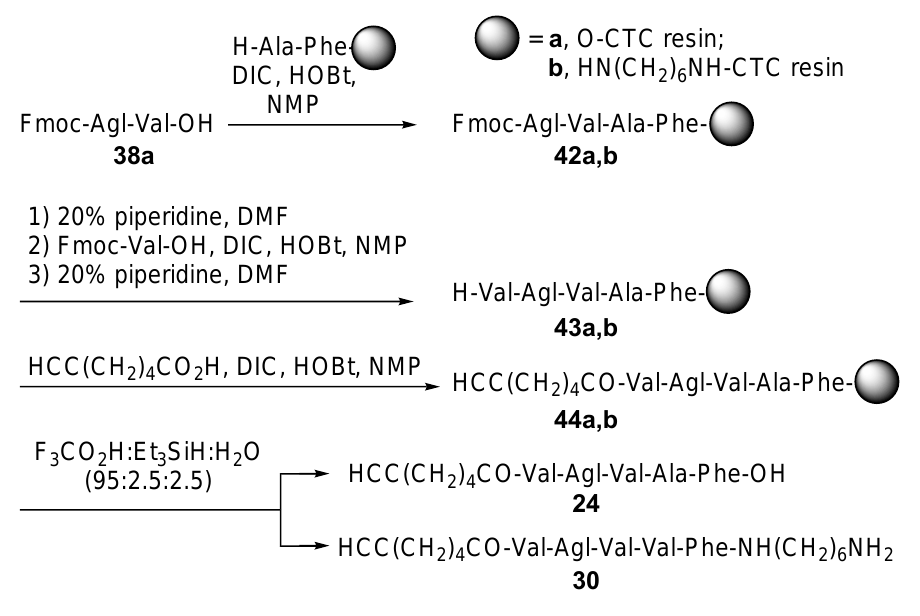
Scheme 1. Representative SPPS (solid phase peptide synthesis) synthesis of almiramides derivatives 24 and 30 .